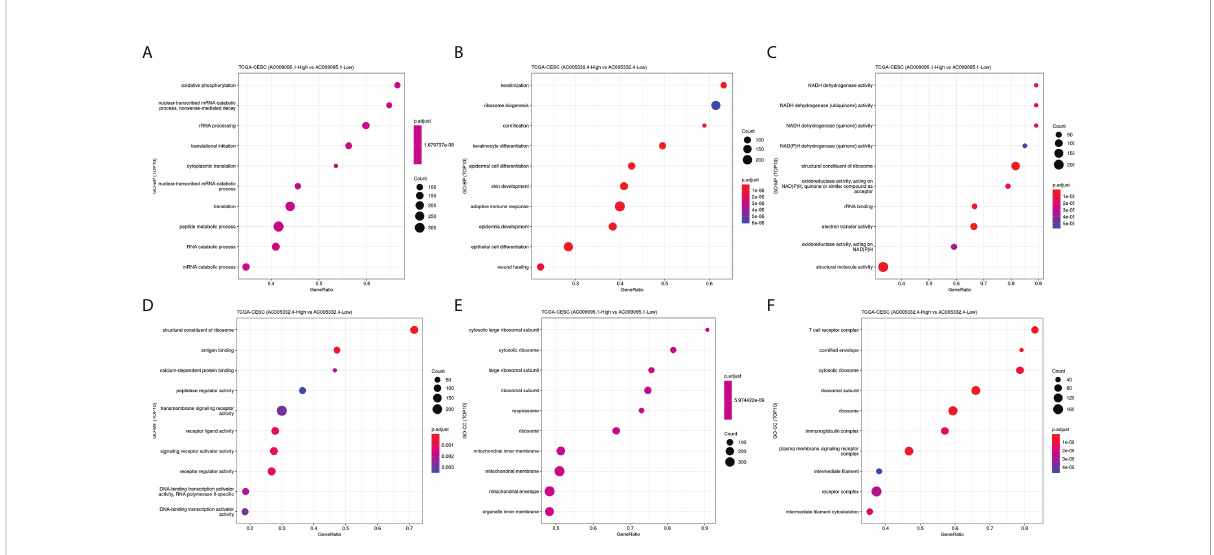
FIGURE 10 Results of GO-BP, GO-MF, and GO-CC. (A) Results of GO-BP in groups of AC009095.1. (B) Results of GO-BP in groups of AC005332.4. (C) Results of GO-MF in groups of AC009095.1. (D) Results of GO-MF in groups of AC005332.4. (E) Results of GO-CC in groups of AC009095.1. (F) Results of GO-CC in groups of